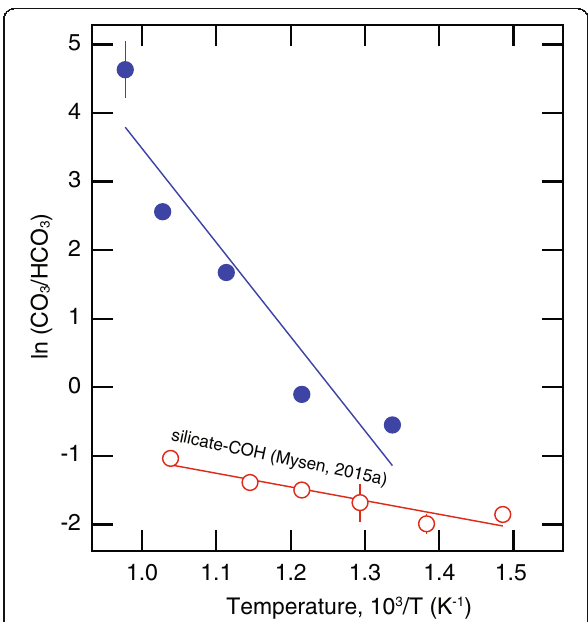
Fig. 14 Abundance ratio, CO 3 /HCO 3 , as a function of temperature (and pressure, see Table 1) in silicate – C – O – H – N melts. The straight line is least squares fitted to the expression, ln(CO 3 /HCO 3 ) = − 13,738 ± 2680/T + 17 ± 3, r 2 = 0.95. Also shown are the experimental data from an aluminosilicate – COH system under similar conditions from Mysen (2015a). Note that the label on the y -axis in the original plot in Mysen (2015a) was inverted. This is corrected for the present figure. The regression line for that regression is ln(CO 32 /HCO 3- ) = − 1999 ± 367/T + 0.9 ± 0.4, r 2 = 0.94